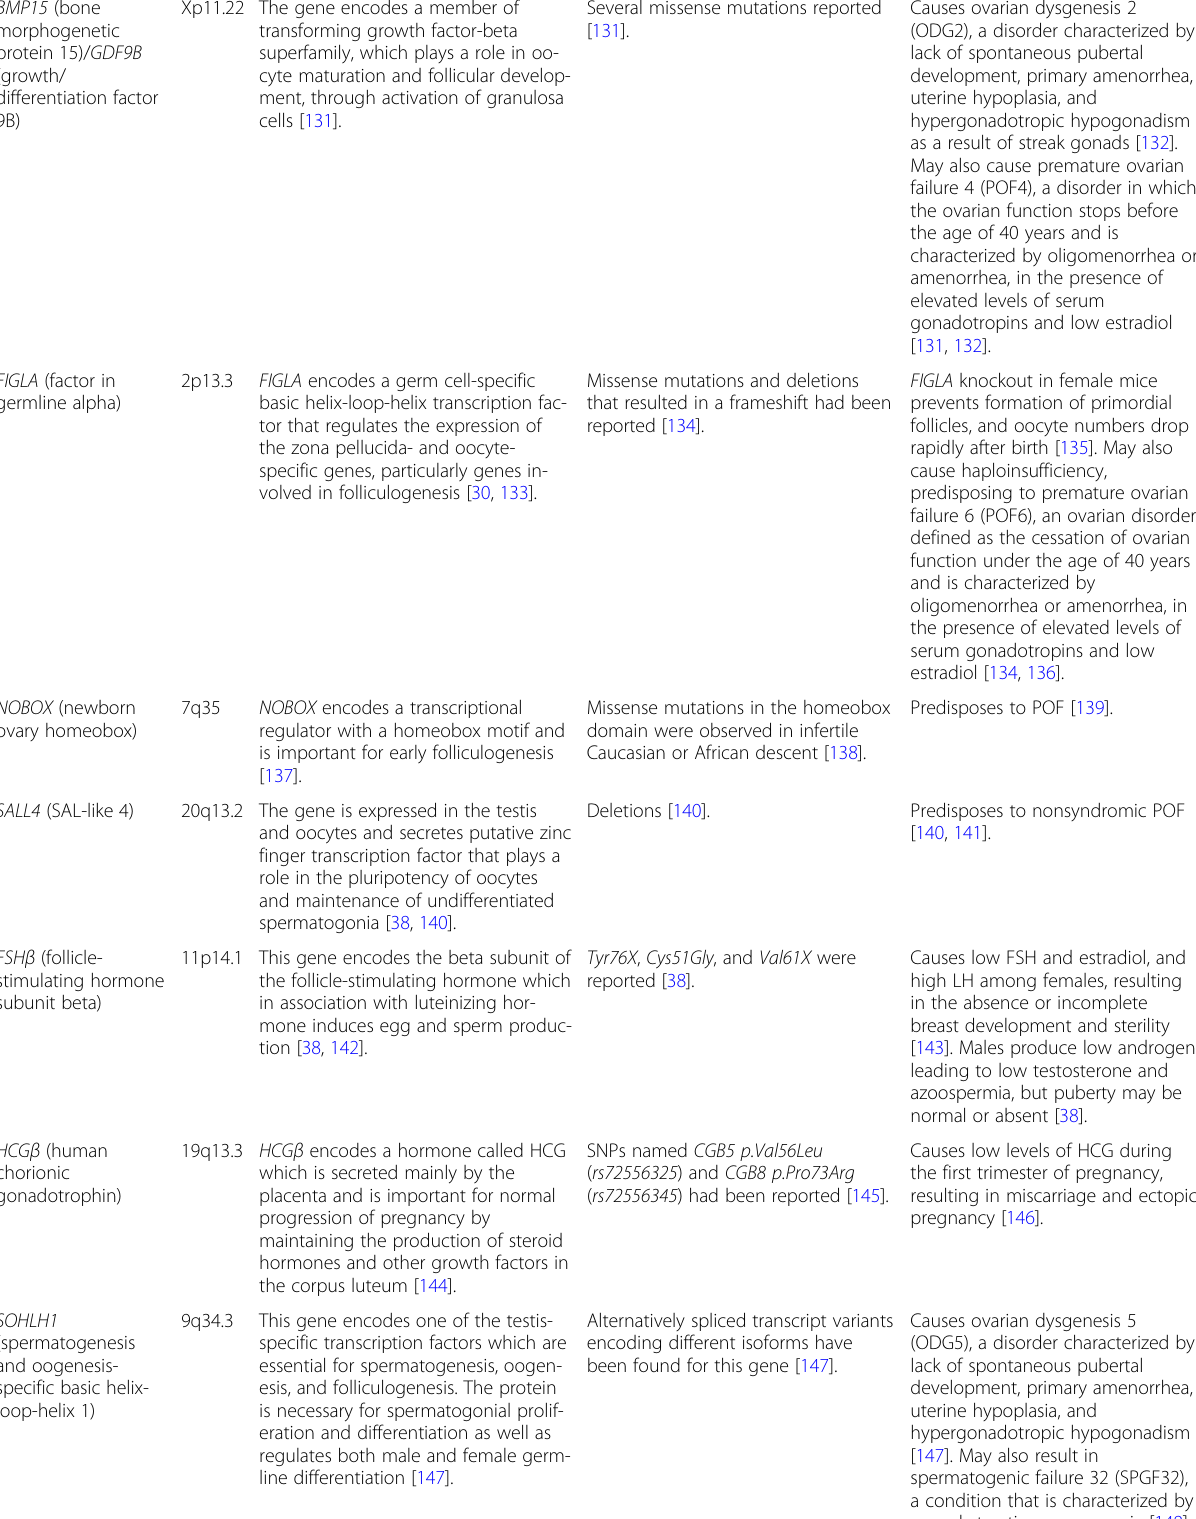
Table 4 Genes predisposing to nonsyndromic ovarian failure BMP15 (bone